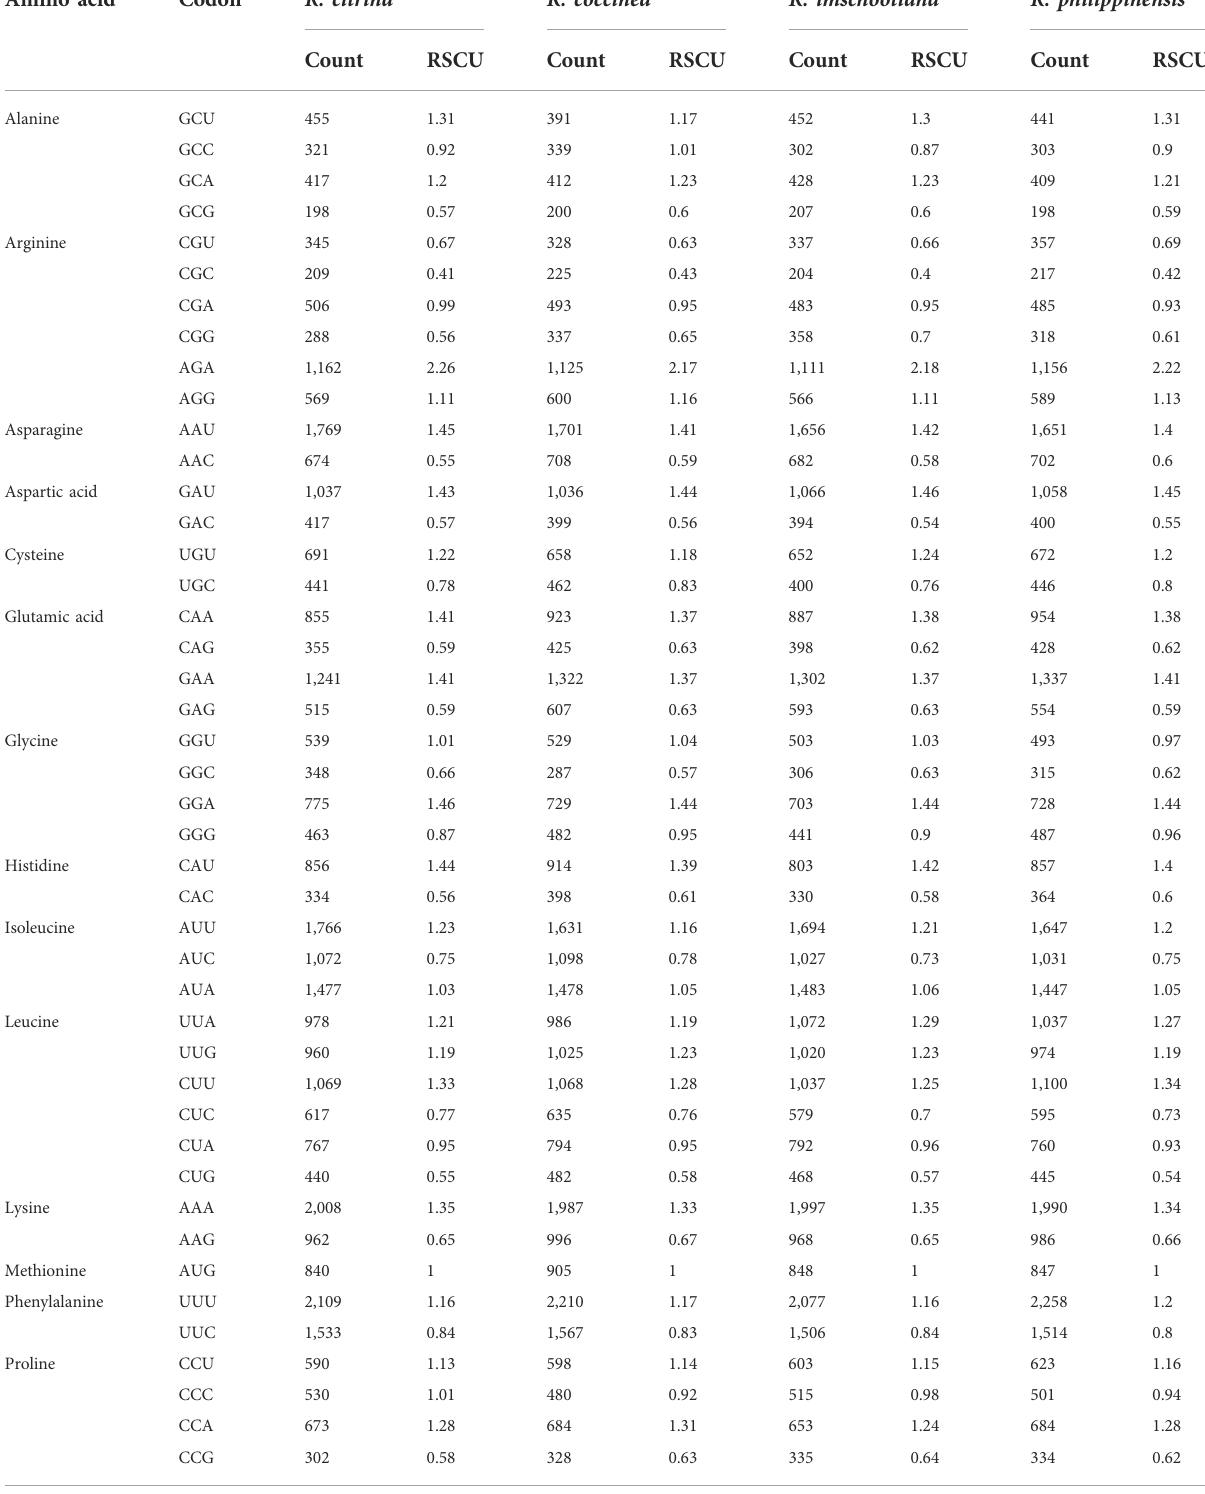
TABLE 3 Relative synonymous codon usage values (RSCU) in plastid genome of four species of Renanthera . Amino acid Codon